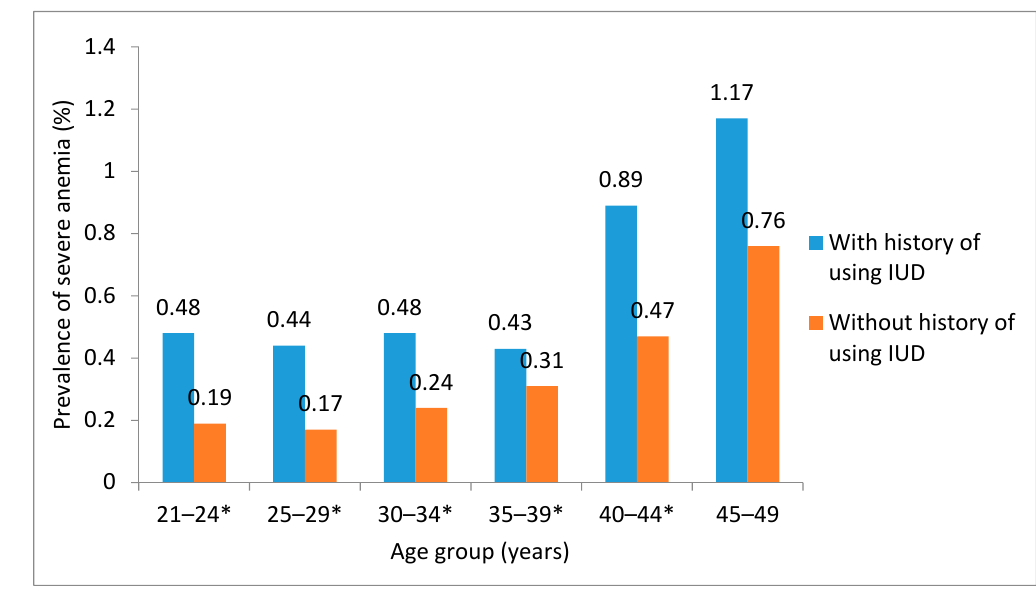
Figure 1. Age-specific prevalence rates of severe anemia in different histories of using intra-uterine device (IUD) in 2012, rural China. * The age group with significant difference in severe anemia prevalence between women with a history of using IUD and those without.